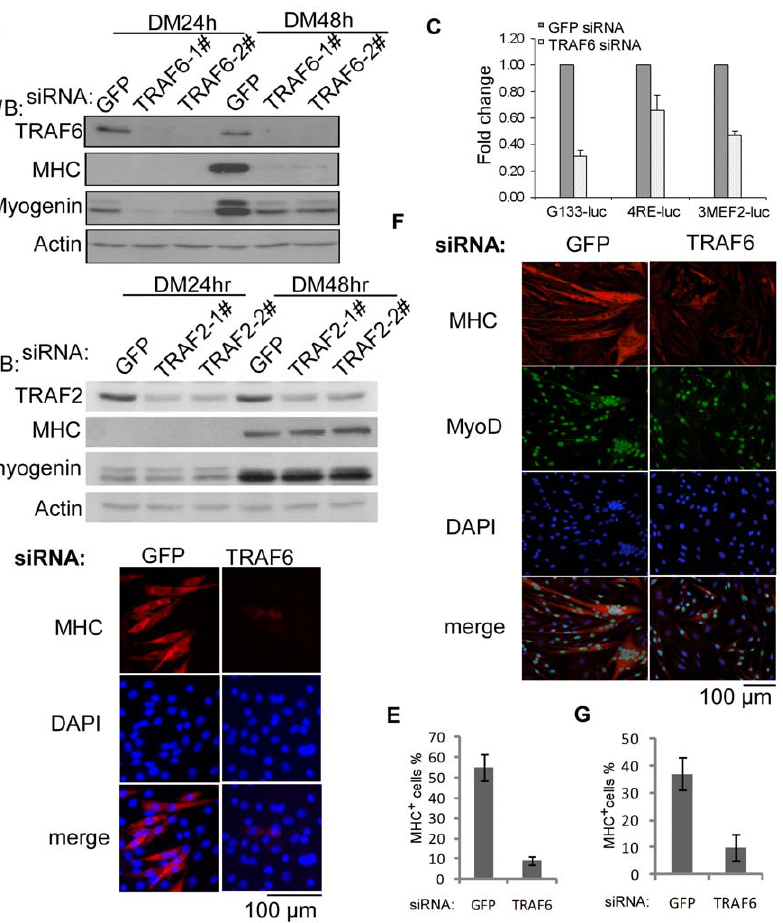
Figure 1. TRAF6 was required for myogenic differentiation. (A, B) C2C12 cells were transfected with a GFP-siRNA, two different TRAF6-siRNAs, or two different TRAF2-siRNAs as indicated. (C) C2C12 cells were transfected in triplicate with either the GFP-siRNA or TRAF6-siRNA together with different luciferase reporter constructs as indicated. Twenty-four hours (h) after transfection, cells were induced to differentiate for 24 h or 48 h before harvest. For (A, B), 60 m g of whole cell extracts (WCE) were subjected to SDS-PAGE and Western blot (WB) analysis for various proteins indicated on the left side of the panels. For (C), cells were harvested after 24 h in DM and WCE were prepared and subjected to luciferase assays. Fold change was calculated as the ratio of the luciferase activity of the TRAF6-siRNA transfected cells over that of the GFP-siRNA transfected cells. The results were presented as mean + s.d. (D–G) C2C12 cells (D, E) or primary myoblasts (F, G) were transfected with the GFP-siRNA or TRAF6-siRNA. Cells were fixed at DM 48 h and subjected to immunostaining for myosin heavy chain (MHC) or MyoD. The nuclei were counterstained with DAPI. In (E, G), the percentage of MHC-positive cells was calculated as the ratio of the number of nuclei in MHC-positive cells over that of DAPI-positive nuclei (E) or MyoD-positive nuclei (G). Cells from five different microscopic fields were counted and the results were presented as mean +